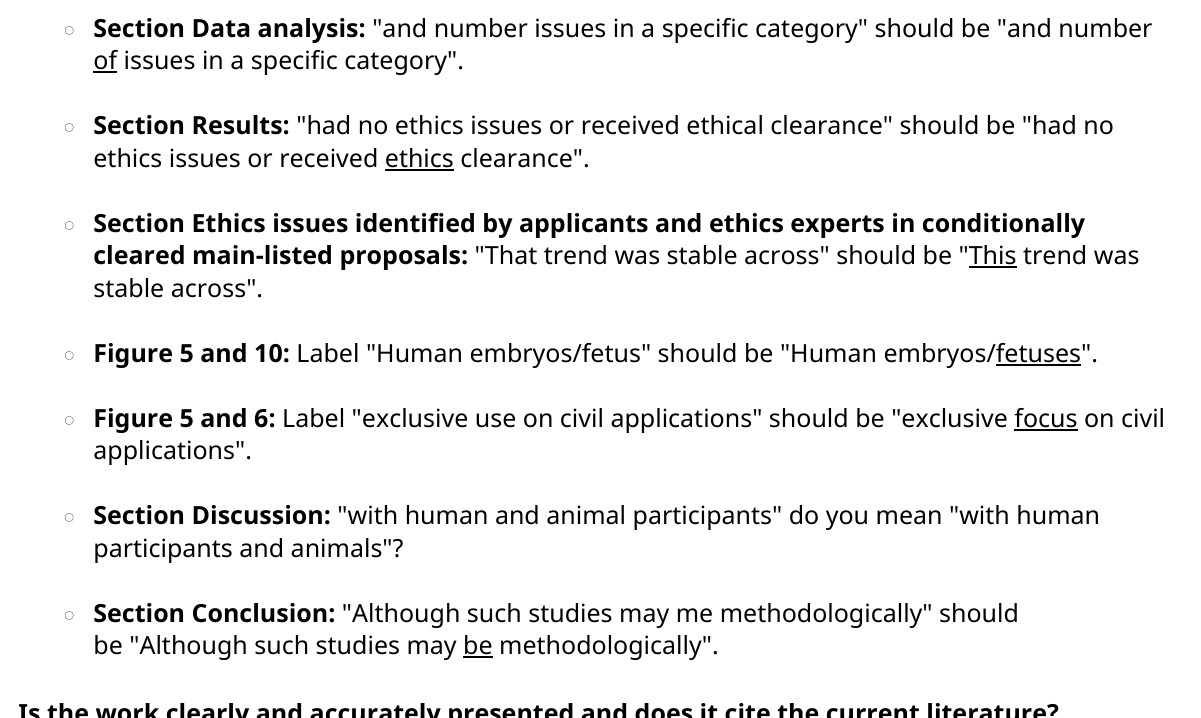
Figure 5 and 6: Label "exclusive use on civil applications" should be "exclusive focus on civil